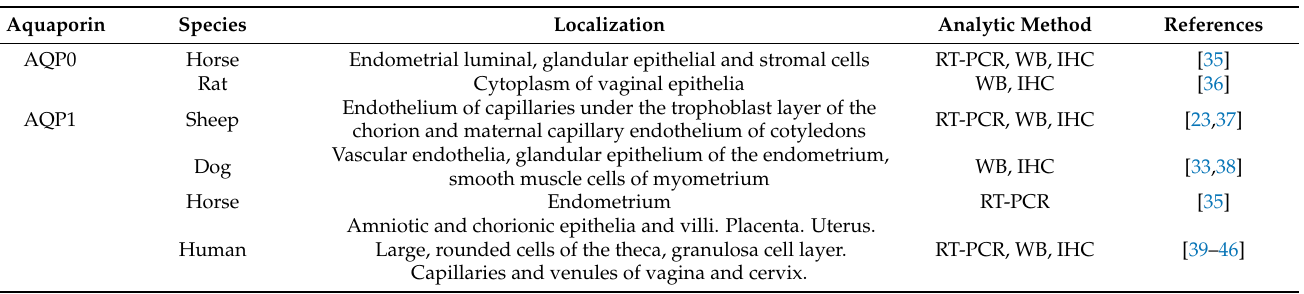
Table 1. Localization of AQPs in the female reproductive tract. Detection method is specified for each aquaporin in each